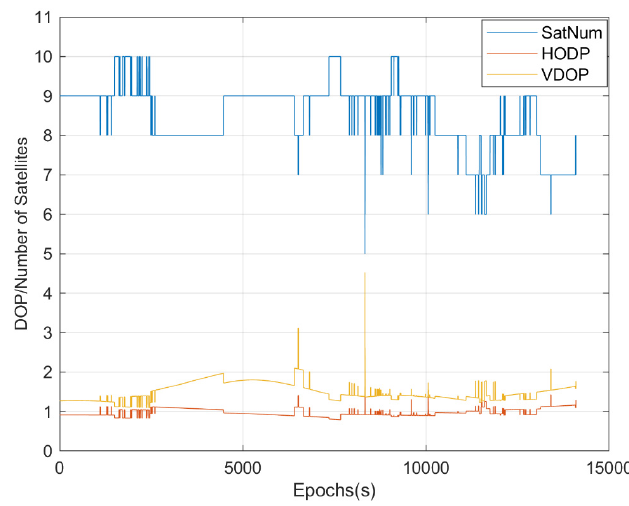
Figure 24. Available augmented satellites number and DOP sequence of the airborne